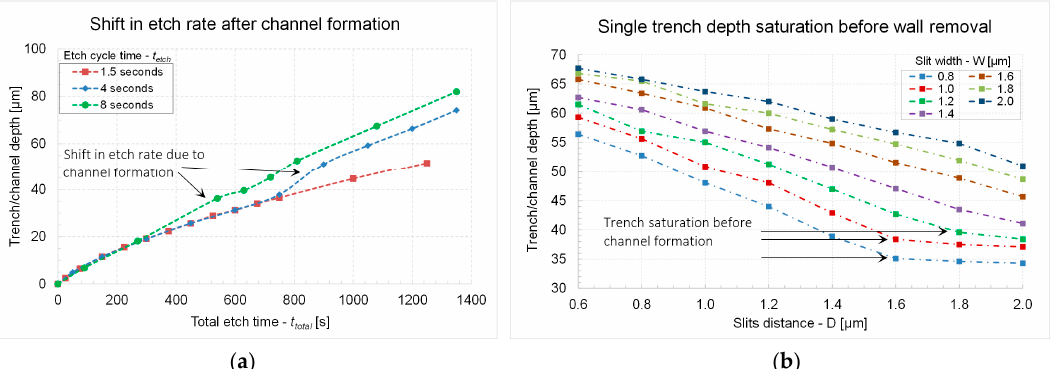
Figure 3. ( a ) The influence of the etch parameters on the channels formation and the etch rate of the structures (fixed design parameters); ( b ) The influence of the design parametrs on the channels formation and the structures depth (fixed process